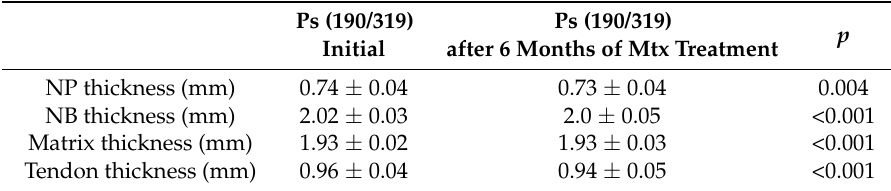
Table 4. US measurements of the fingers in patients with psoriasis.